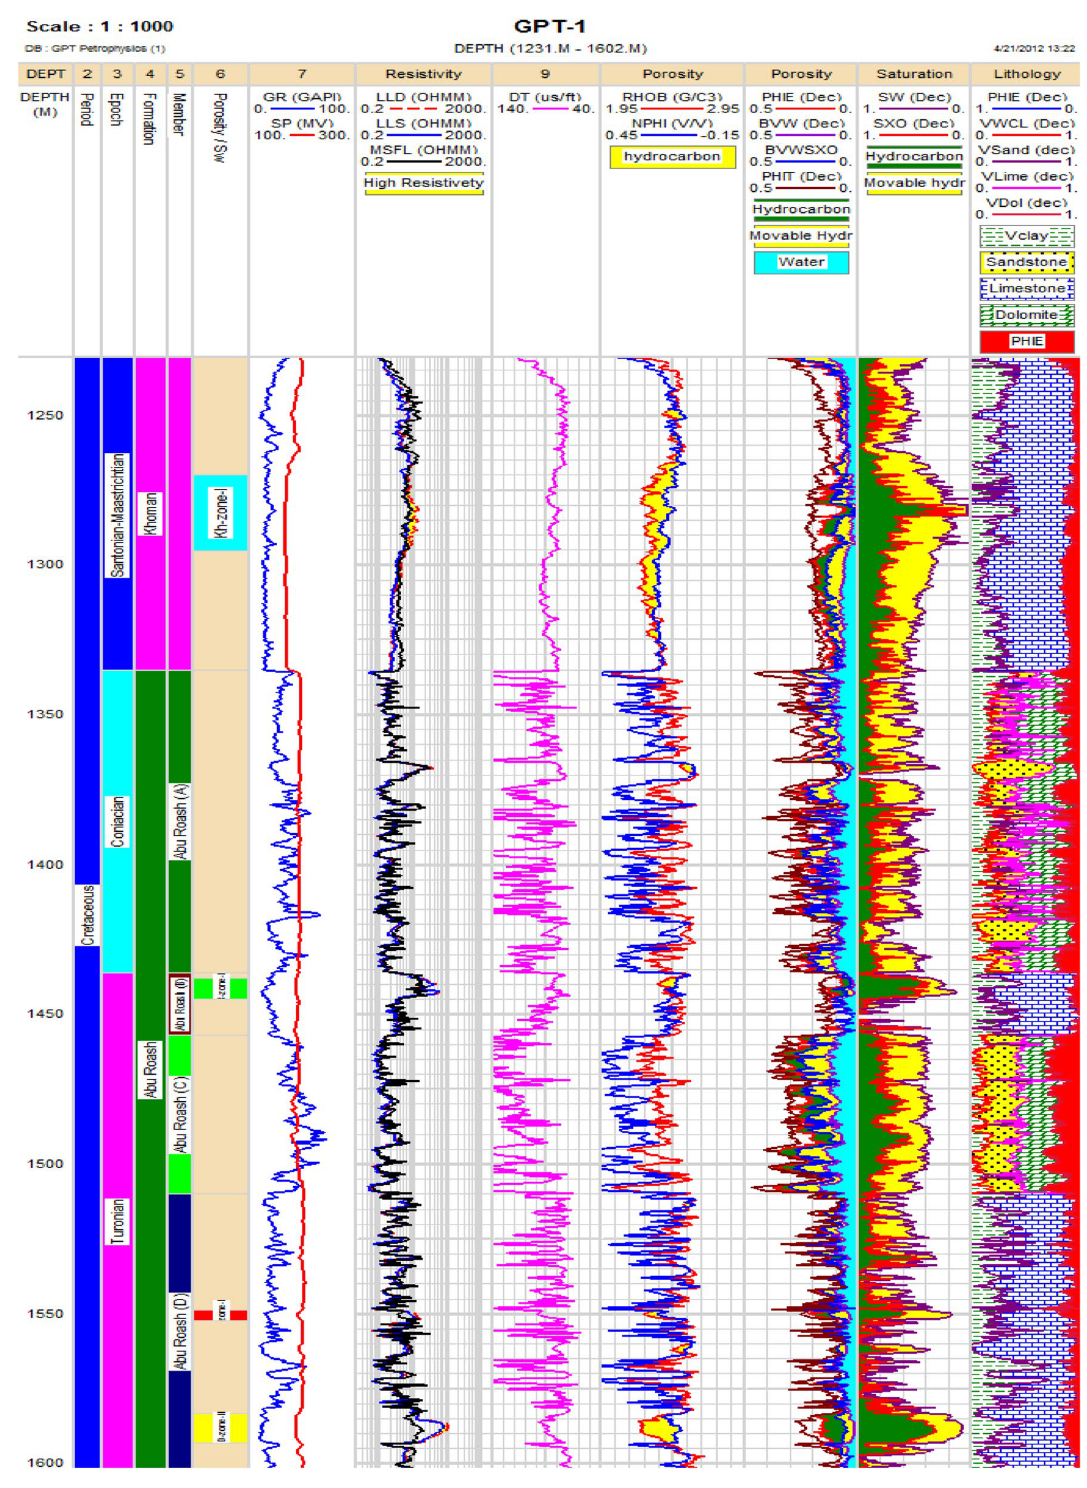
Fig. 10 Lithosaturation cross-plot of Khoman Formation and Abu Roash Formation (A, B, C and D members) in GPT-1